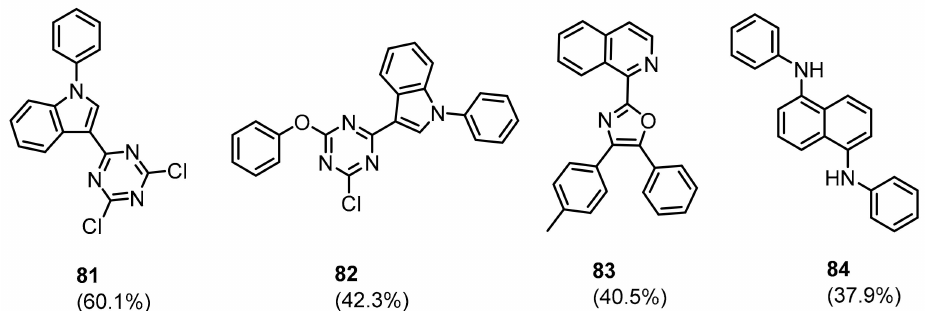
Figure 34. Structures of PD-1 binders reported by Patil and co-workers [89].